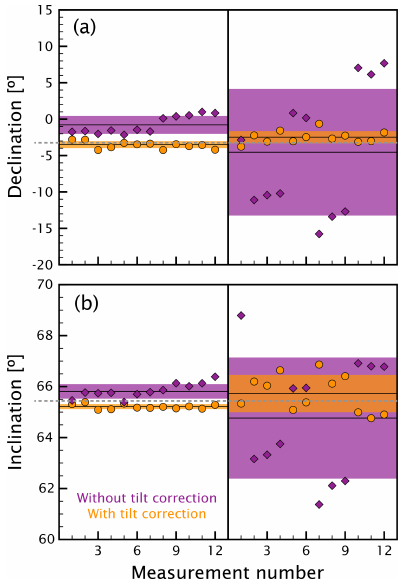
Figure 4. Comparison of the declination (a) and inclination (b) be- fore and after tilt correction. We did 12 measurements while care- fully positioning the AnomalyMapper upright using the bubble level (deviation form vertical < 3 ◦ , left-hand side of both panels) and 12 measurements with the AnomalyMapper more or less upright (devi- ation form vertical up to 25 ◦ , right-hand side of both panels). Each measurement is plotted with (orange circles) and without (purple di- amonds) tilt correction; the averages of groups of 12 measurements are given as horizontal black lines with their associated 1 standard deviation intervals as shading in the corresponding color. The gray dashed lines are the independently measured values of the Earth’s magnetic